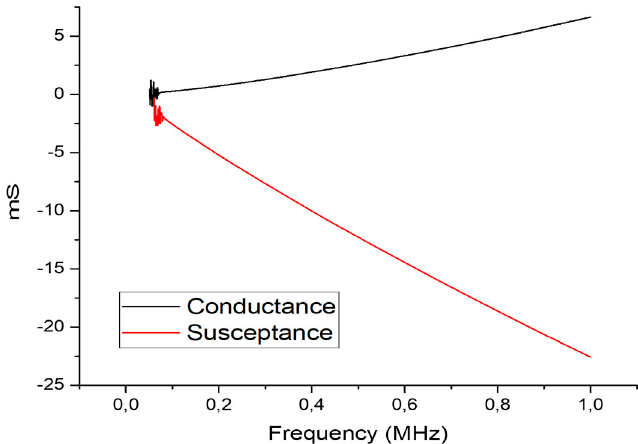
Figure 5. Admittance (conductance + susceptance) measurements from 60 kHz to 1 MHz using a network analyzer Keisight E5071C.